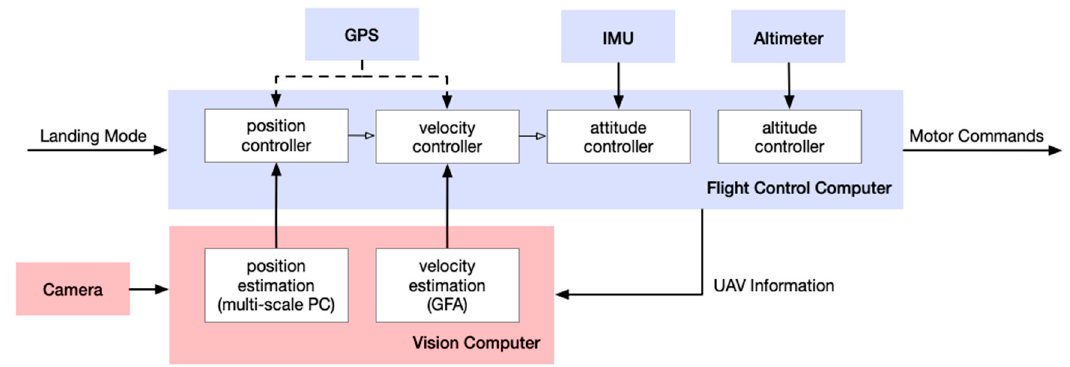
Figure 8. The onboard system architecture of the UAV. According to the landing mode, both position and velocity estimates were obtained from GPS or the vision system respectively, and, the multi-loop feedback scheme was designed for flight control in order to keep the commanded position.